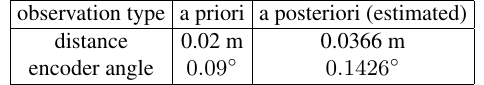
Table 3: Initially assumed and estimated standard deviations for the observations (var. comp. estimation).